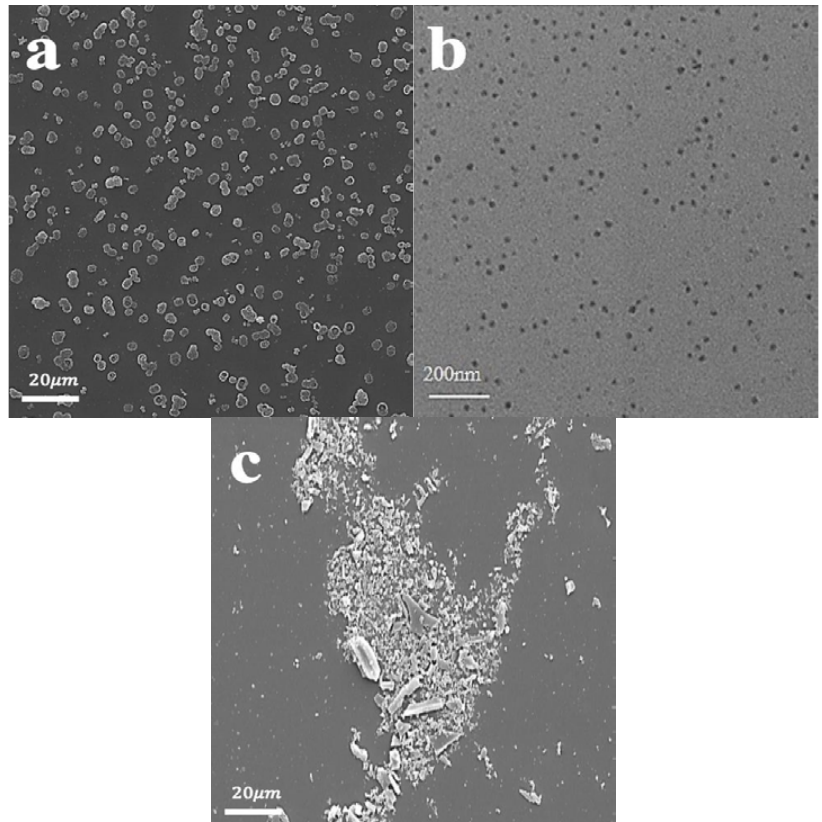
Fig. 2. The SEM image of (a) boron oxide (b) catalyst and (c) activated